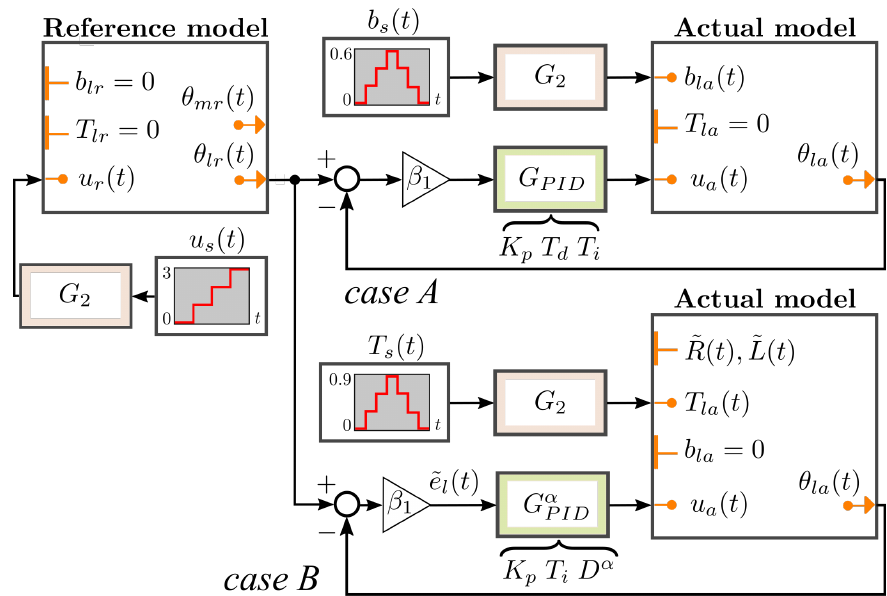
Figure 3. Block diagram of the closed-loop model reference Proportional Integral Derivative (PID) control with the additional time-dependent disturbances of the damping coefficient b la ( t ) (case A) and the loading torque T la ( t ) (case